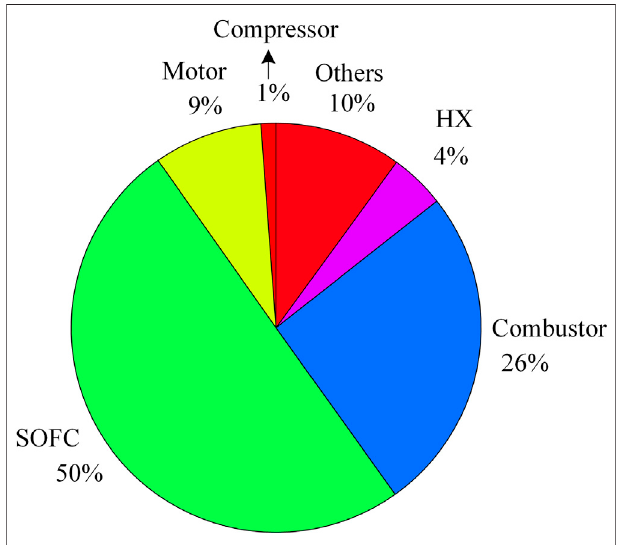
FIGURE 5 | Component mass of the HEFC engine.